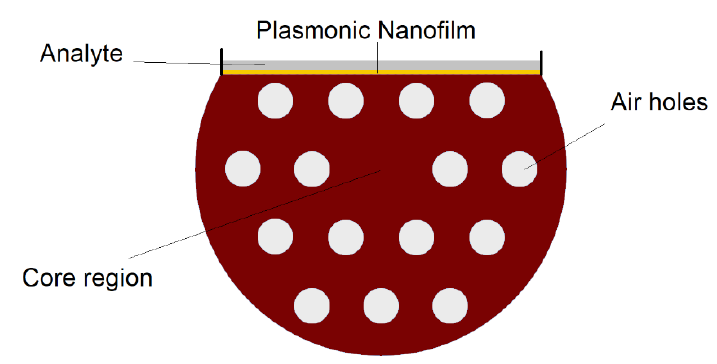
Figure 13. Cross section of D-shaped PCF-surface plasmon resonance (SPR) biosensor that can be used to detect analytes with low or high refractive indices, depending on the design parameters.